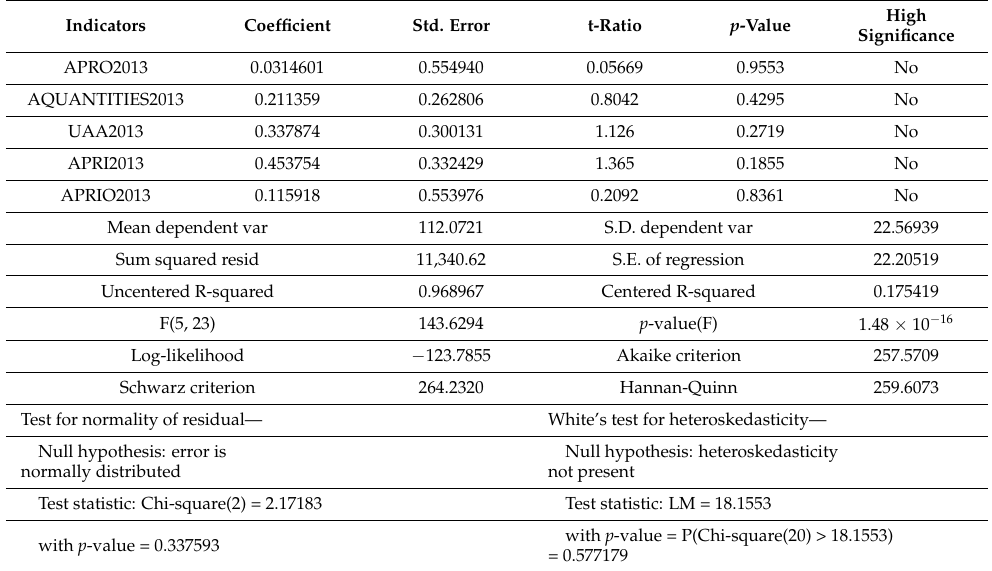
Table 3. Model 2013: OLS, using observations 1–28 (Dependent variable: AINCOME2013).